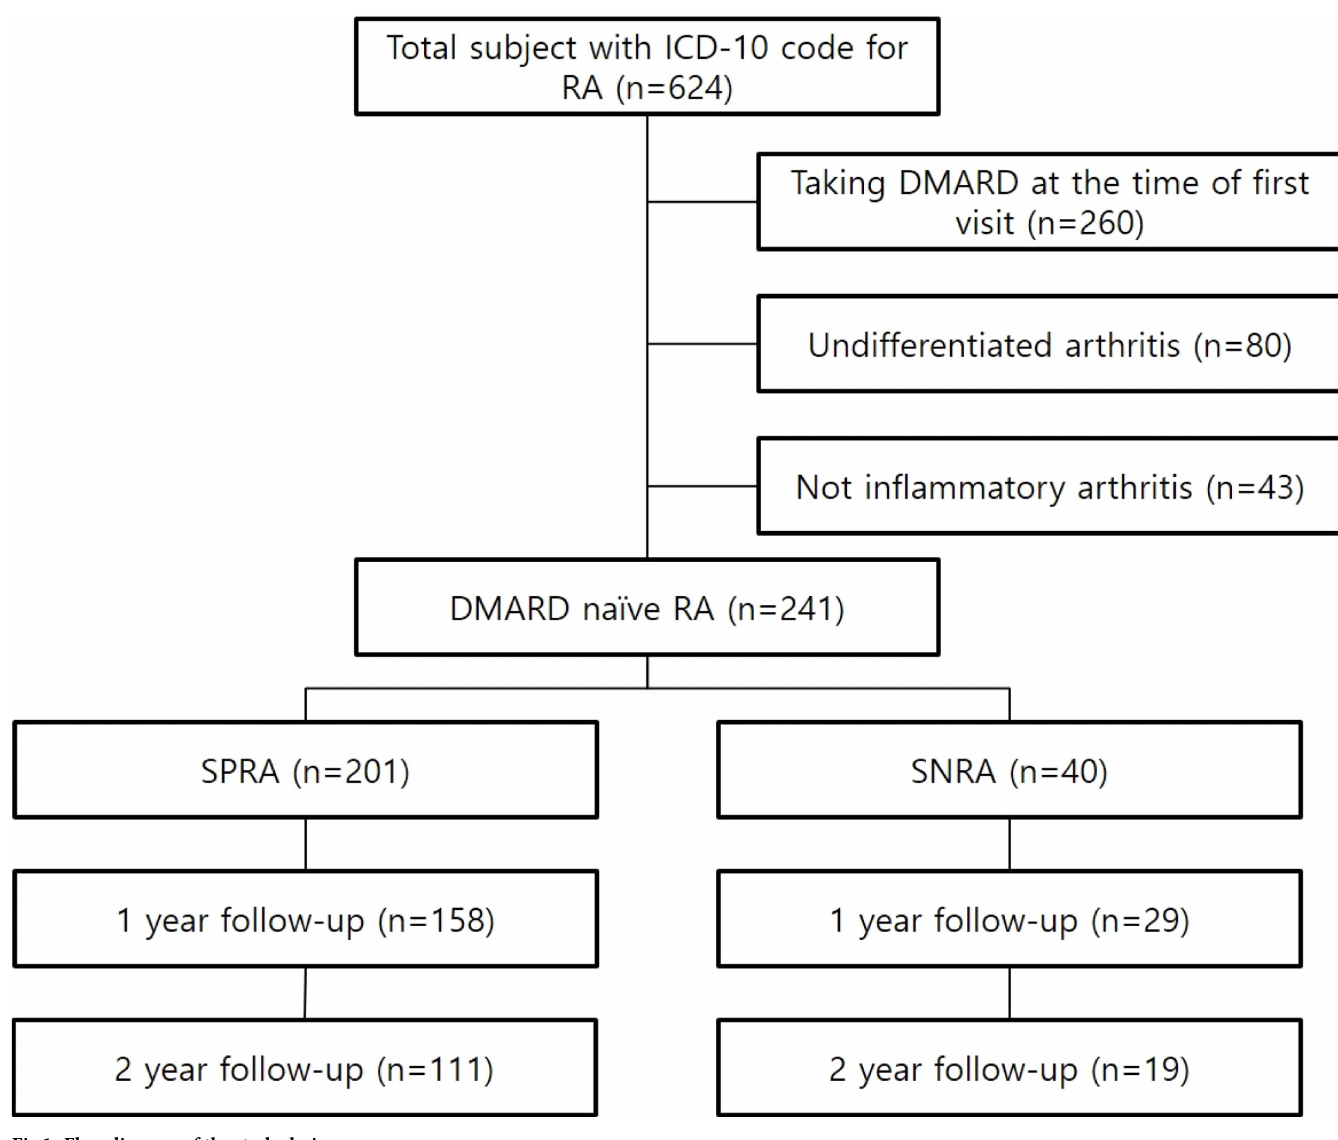
Fig 1. Flow diagram of the study design.